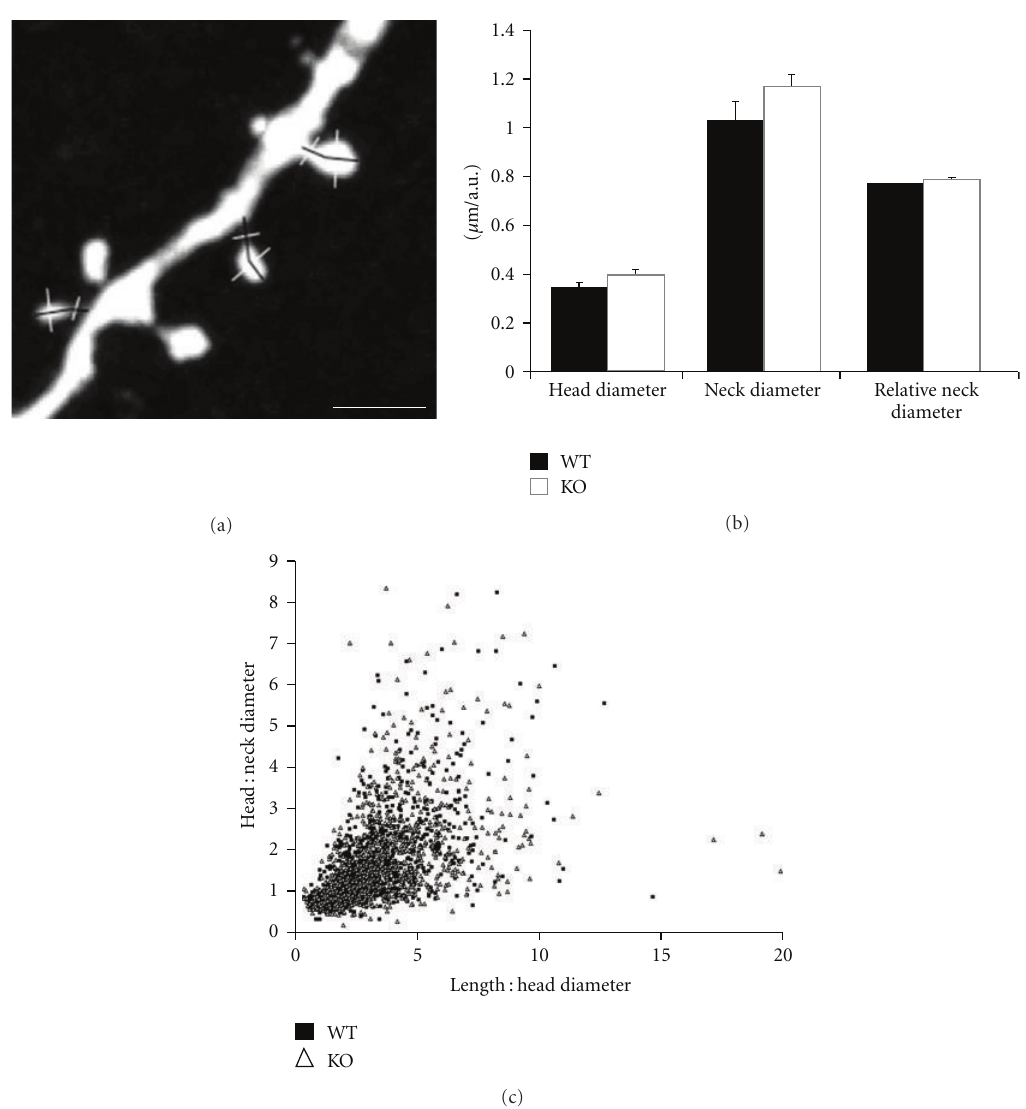
Figure 4: Morphological analysis of dendritic spines. (a) Black lines indicate measurements of spine length. White lines indicate trajectories across which profiles of fluorescence were obtained from the spine head and neck. Scale bar: 2 μ m. (b) Measures of spine head diameter, neck length, and relative neck diameter did not di ff er significantly between WT and prestin KO animals in layer 2/3 ( P > . 05). (c) Spines can be loosely classified into morphological “types” by comparing their relative head, neck, and length dimensions. The complete overlap of WT spines with KO spines indicates that there is no di ff erence in spine type distribution between